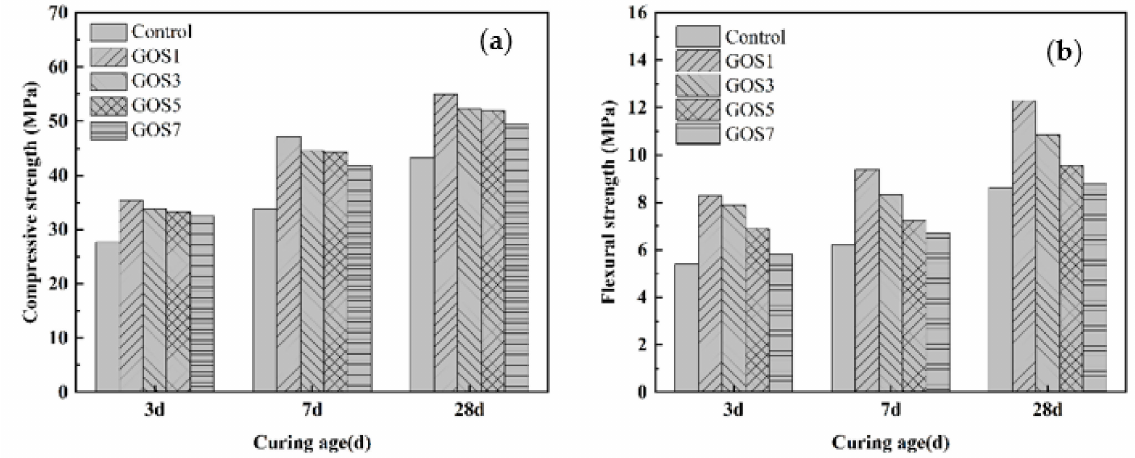
Figure 10. Strengths of cement-based materials with different GOS concentrations: ( a ) Compressive Strength. ( b ) Flexural